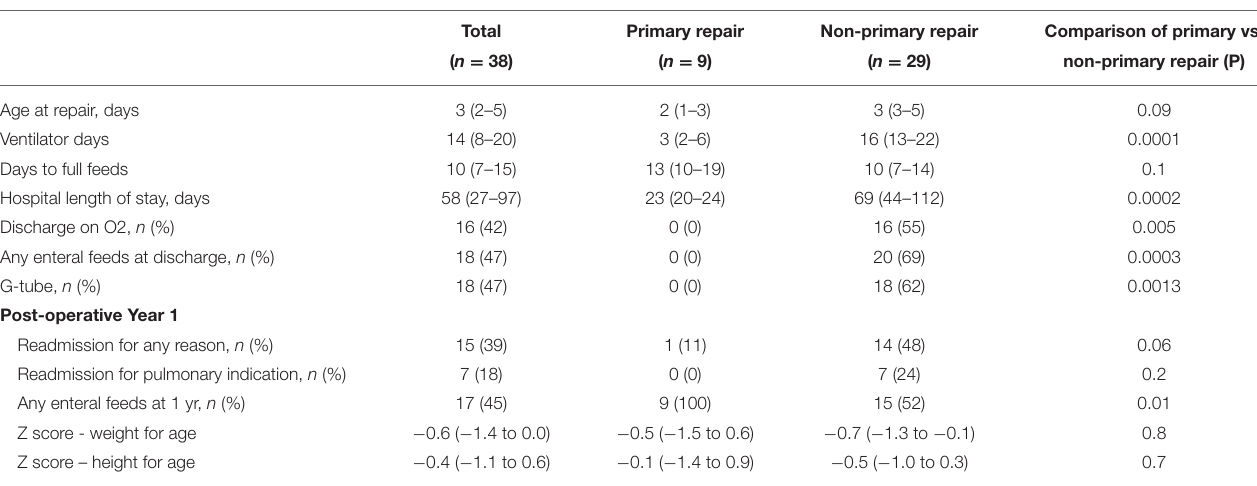
TABLE 2 | Patient